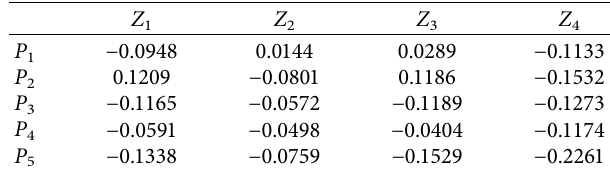
Table 11: Distance matrix.